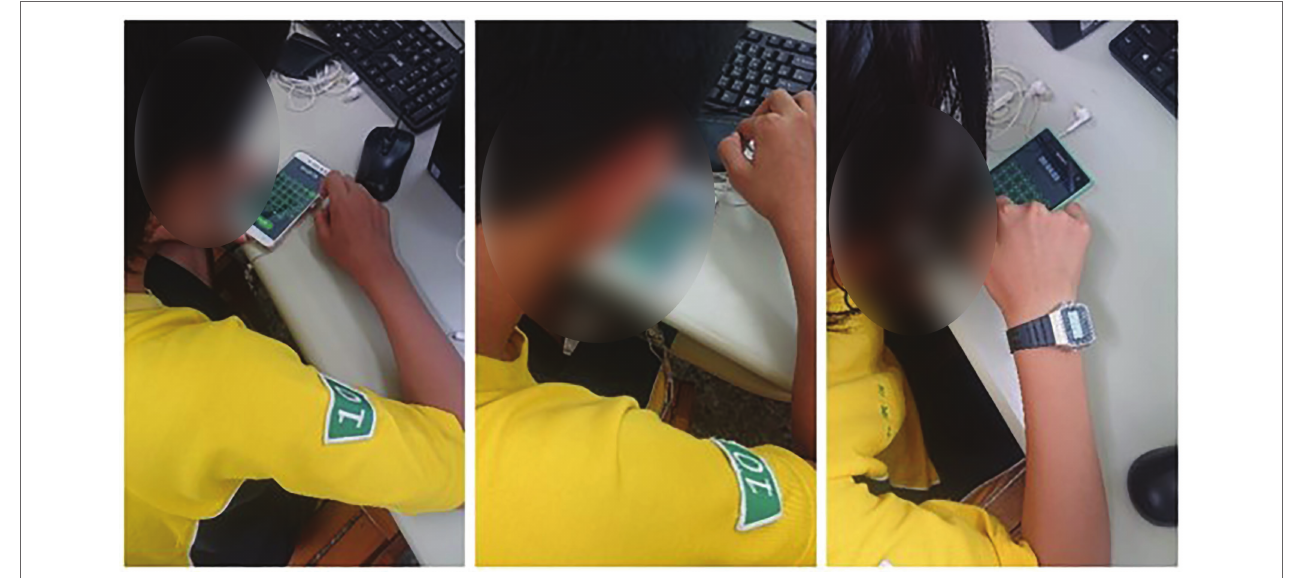
FIGURE 5 | Learning activities for